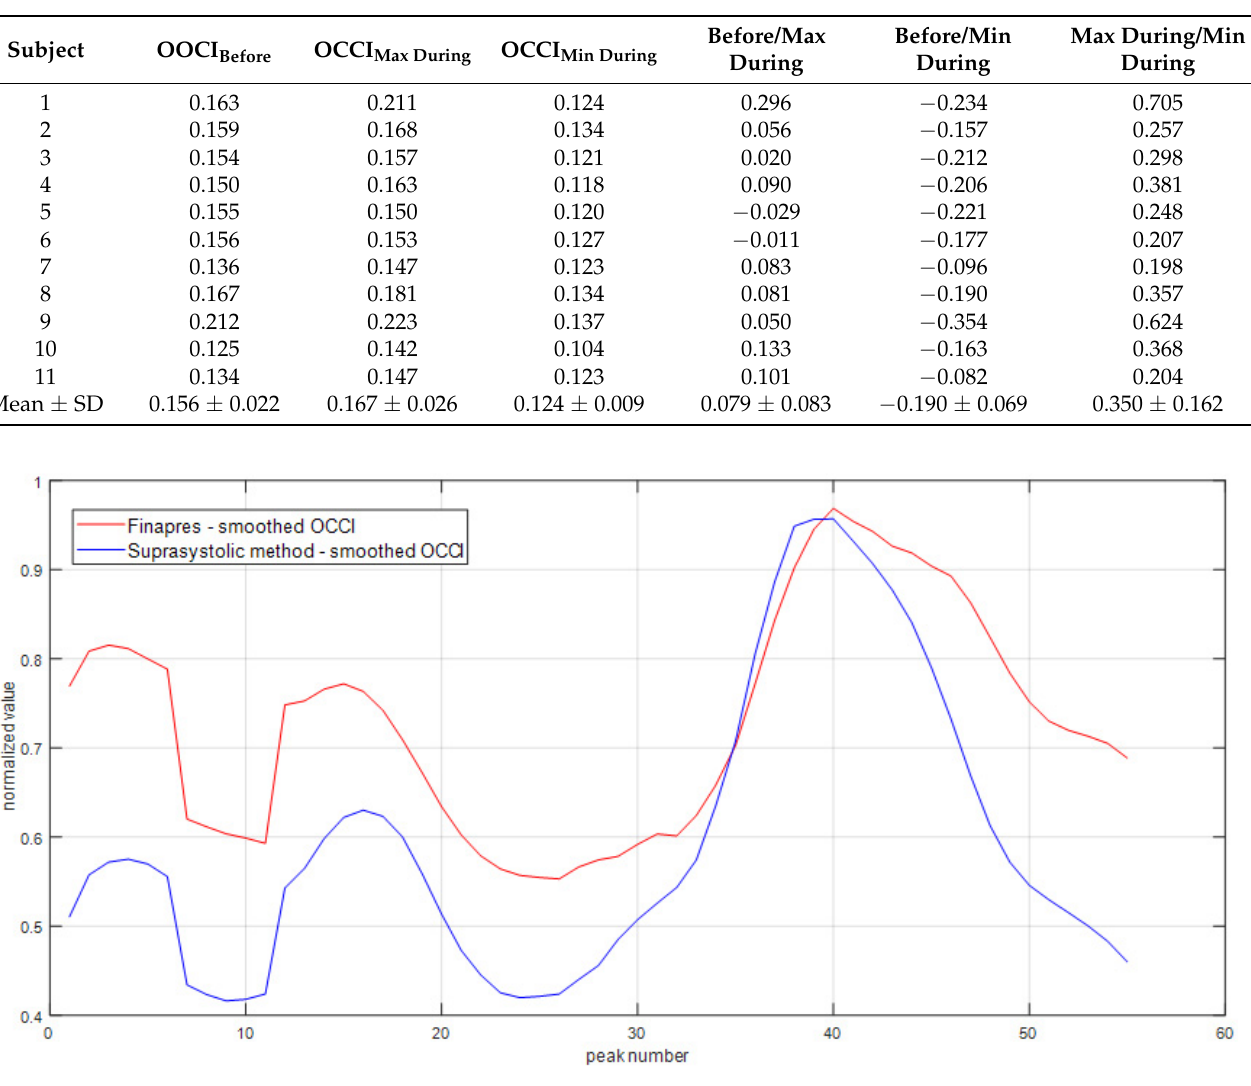
Table 2. Calculation of percent change of OCCI. OCCI is defined as a systolic area under the individual pulse wave divided by its amplitude and in the table are mean values of OCCI index from every patient and his every Valsalva measurement. In total, compared to the resting state, there was 8% increase, 19% decrease and percent change during maneuver (max/min) was 35%.